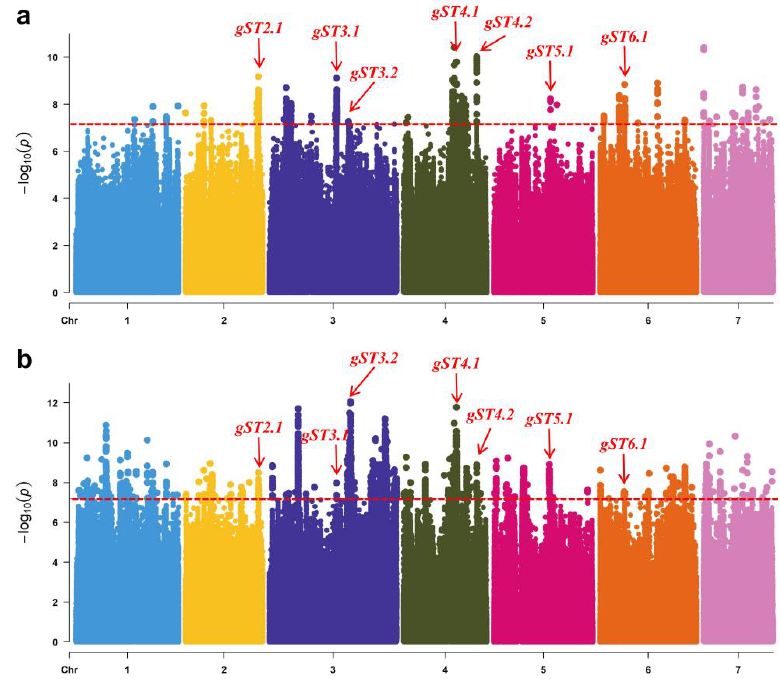
Figure 4. Genome-wide association analysis (GWAS) Manhattan plots of salt tolerance in two experiments: ( a ) Salt_2020 and ( b ) Salt_2021. The different colors represent the different chromosomes. The red dashed line represents the significance threshold. The red arrow indicates the position of the strong peaks that were repeatedly detected in the two